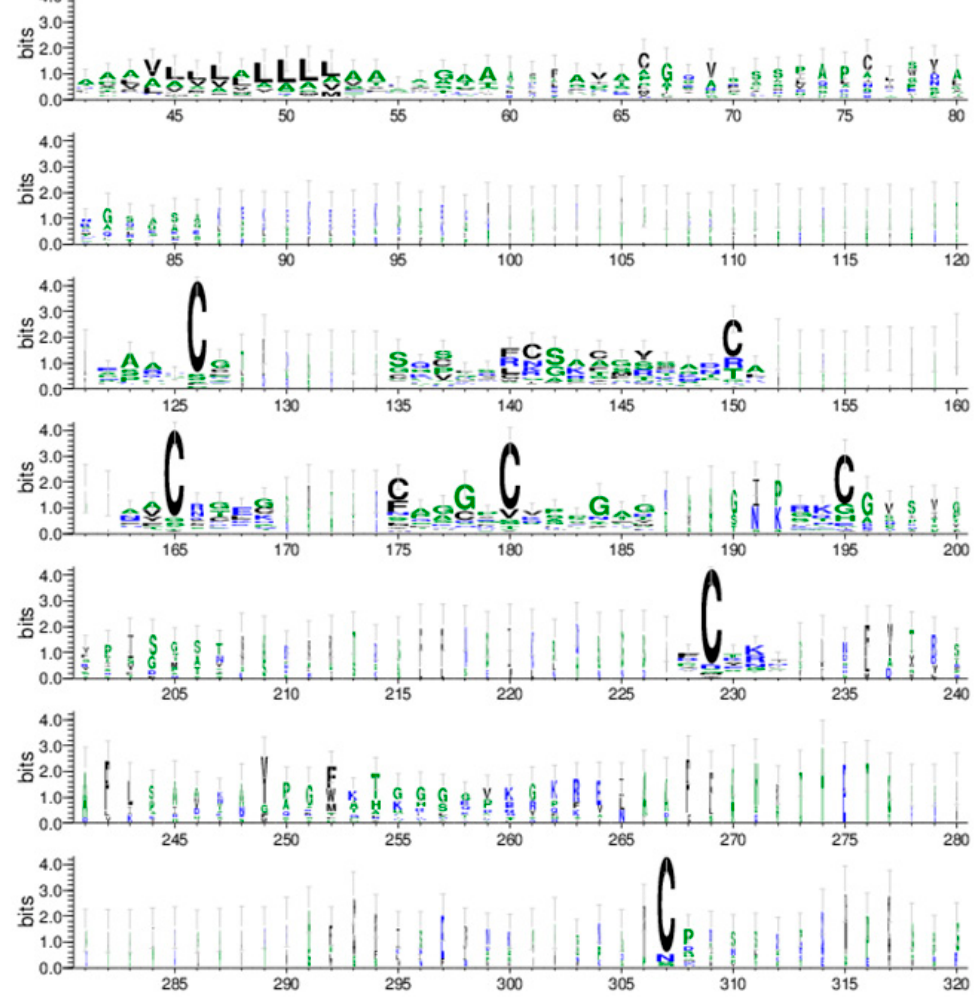
Figure 2. A WebLogo graph showing the positions of highly conserved cysteine-rich motifs observed among all forty-six maize AMP sequences. The degree of conservation is indicated by the relative size of the single-letter amino acid code.